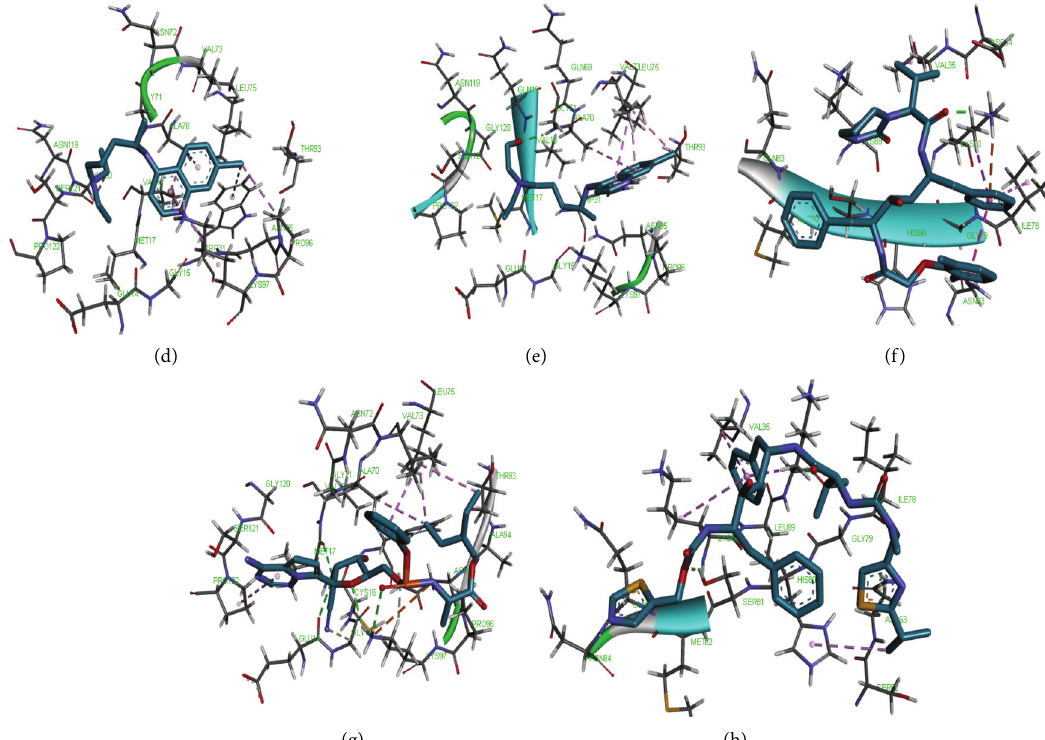
Figure 4: 3D representation of (a) 3-galloylcatechin, (b) proanthocyanidin B1, (c) luteolin 7-galactoside, (d) chloroquine, (e) hydrox- ychloroquine, (f) lopinavir, (g) remdesivir, and (h) ritonavir in the binding pocket of 3CLpro.